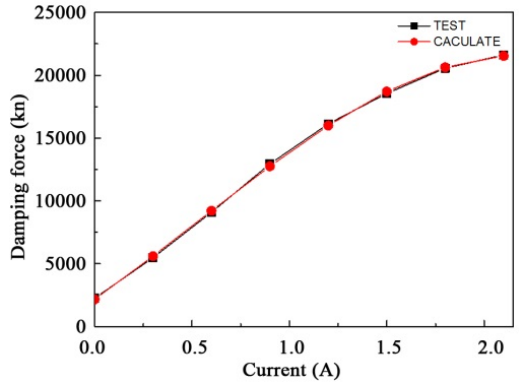
Figure 7. Relation diagram for current and damping force.